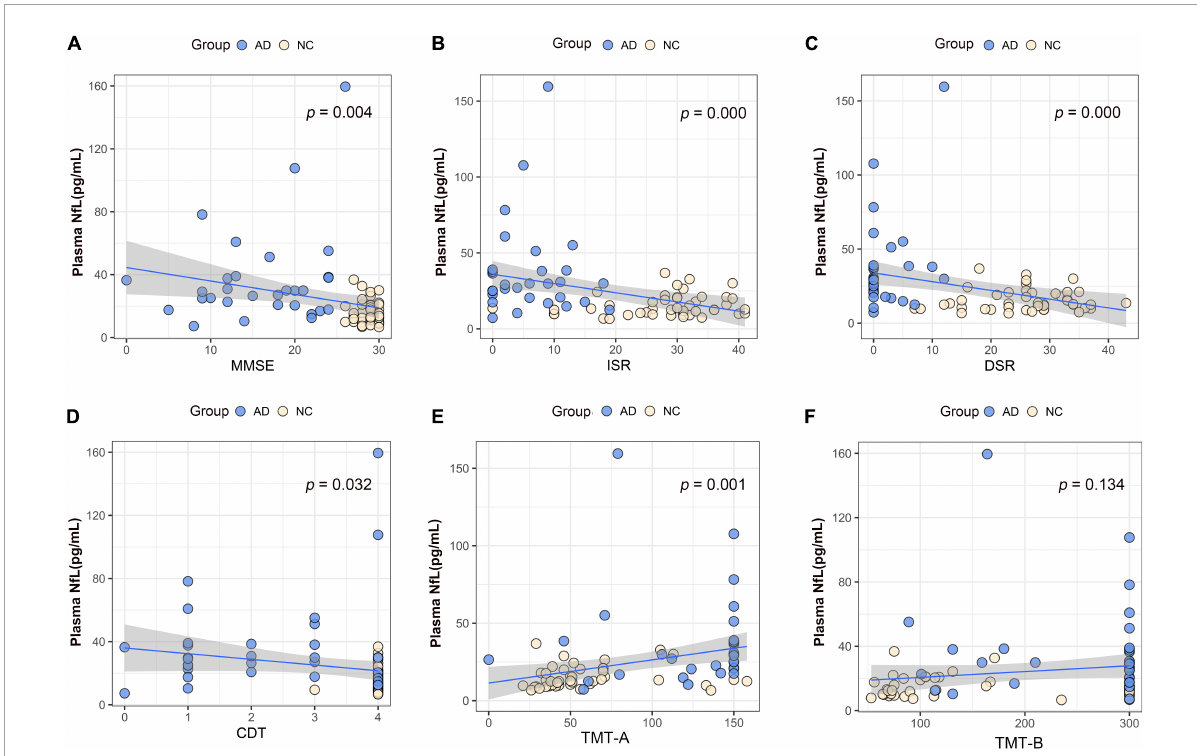
FIGURE4 Association between plasma neurofilament protein light chain (NfL) and cognitive domains. (A) Association between plasma NfL and MMSE. (B) Association between plasma NfL and ISR. (C) Association between plasma NfL and DSR. (D) Association between plasma NfL and CDT. (E) Association between plasma NfL and TMT-A. (F) Association between plasma NfL and TMT-B. Multiple regression analysis was used and adjusted for years of education. AD, Alzheimer’s diseases; NC, normal control; MMSE, Mini-Mental Status Examination; ADL, Activity of Daily Living; ISR, Immediate story recall; DSR, delayed Story Recall Scale; CDT, clock drawing test; TMT-A, trail making test A; TMT-B, trail making test B; pg/ml,